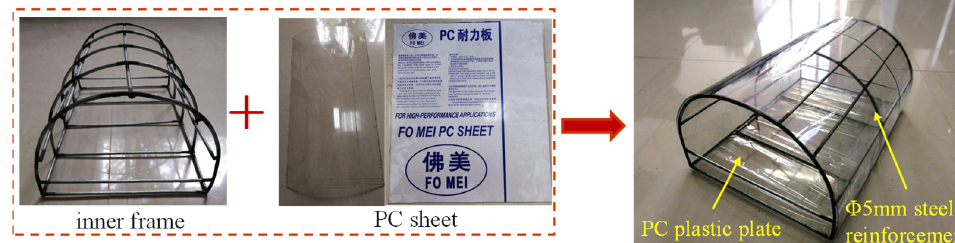
Figure 1. Composition of roadway